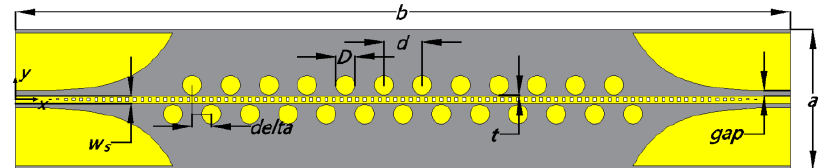
Figure 6. The structure of the SSPP leaky-wave antenna. D = 10 mm, delta = 10 mm, d = 20 mm, t = 0.5 mm, ws = 4 mm, gap = 0.5 mm.